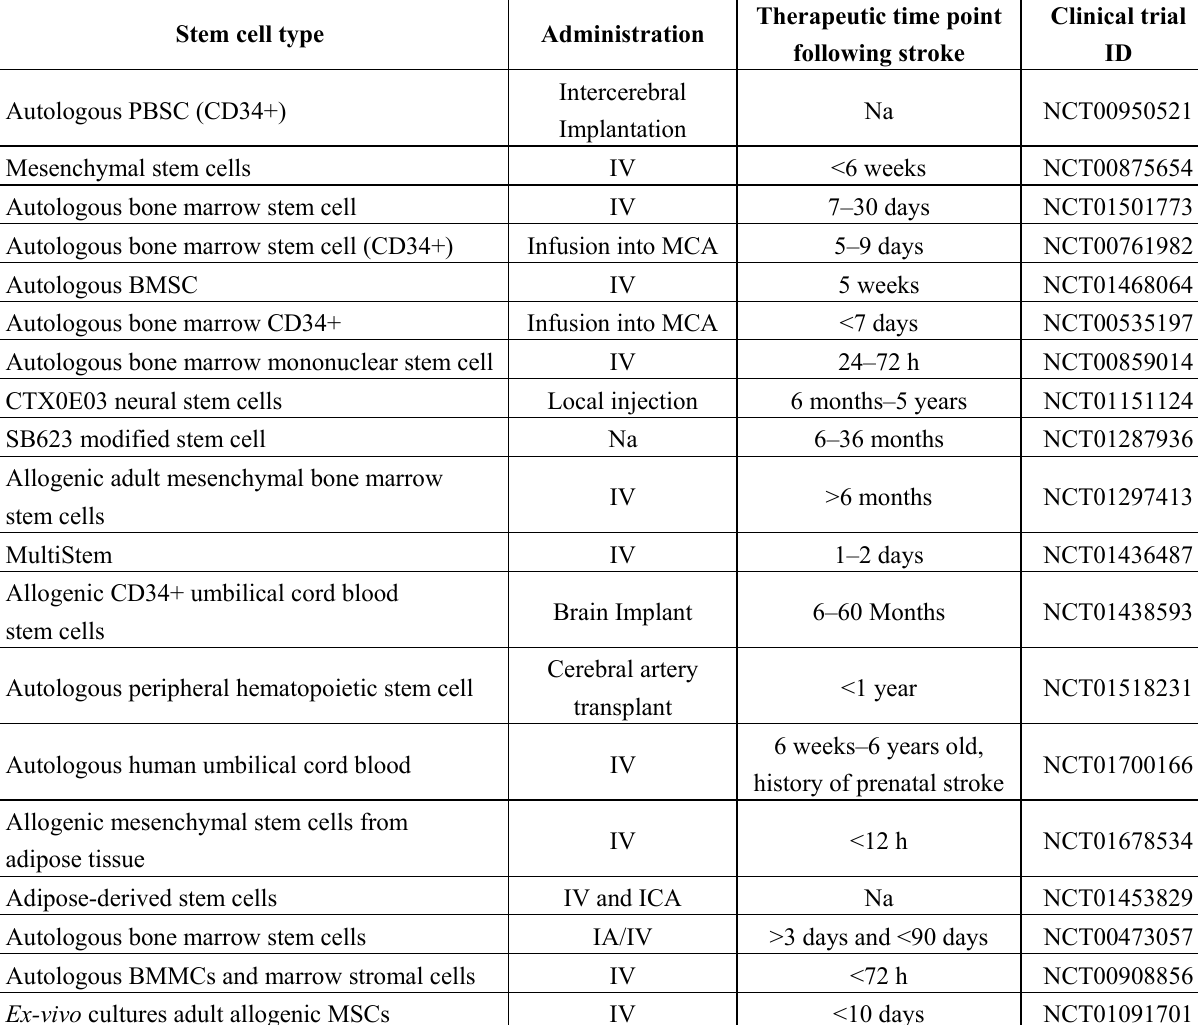
Table 1. Ongoing clinical trials of stem cell therapies for ischemic